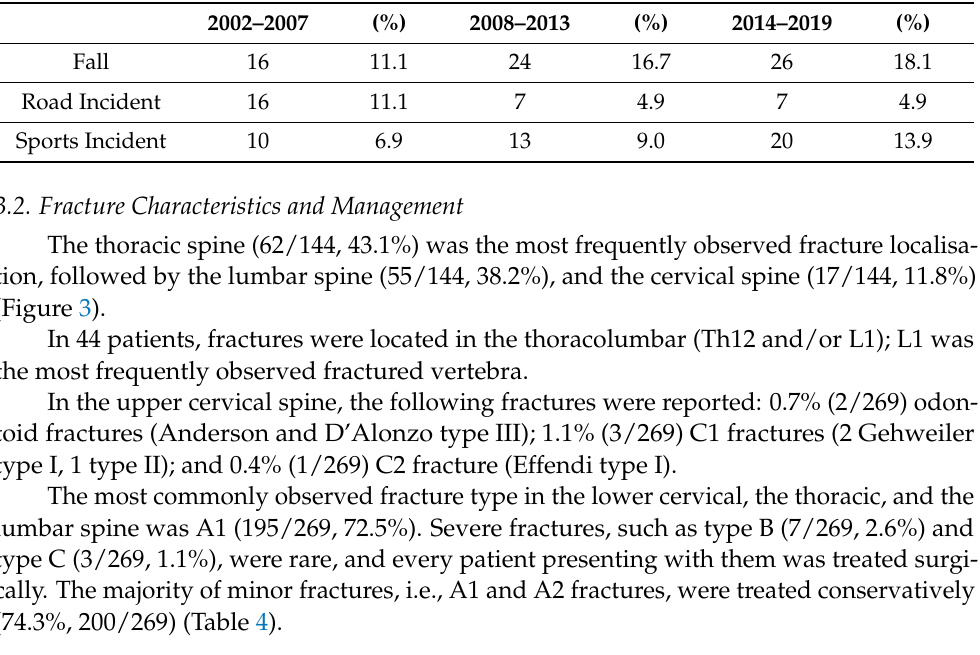
Table 3. Distribution of injury mechanisms from 2002 to